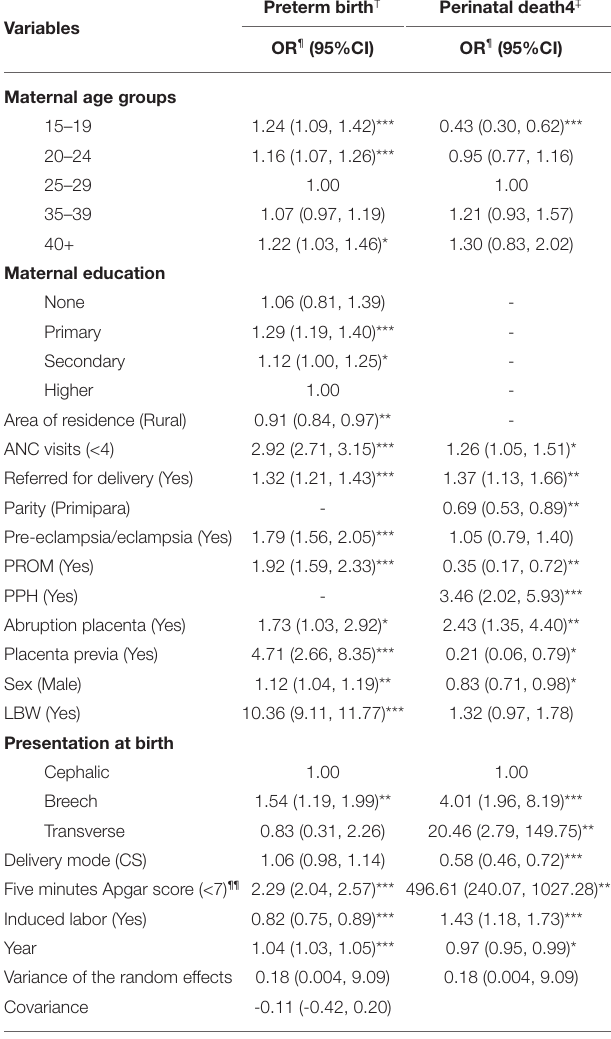
TABLE 3 | Joint predictors of preterm birth and perinatal death with separate but correlated random effects.